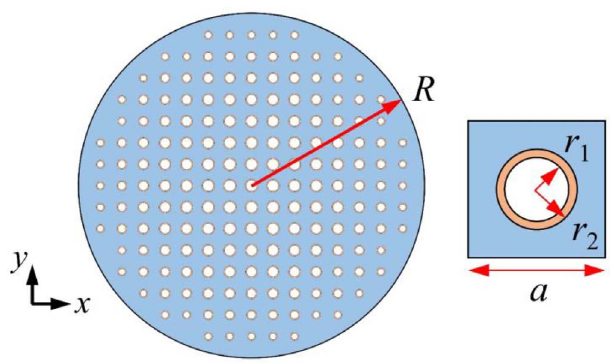
Figure 3. Acoustic Luneburg lens designed by square lattice and its unit